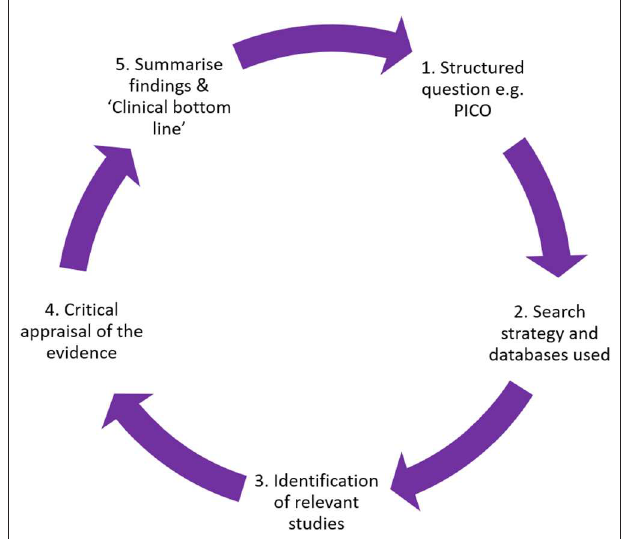
FIGURE 2 | Diagrammatic overview of the CAT